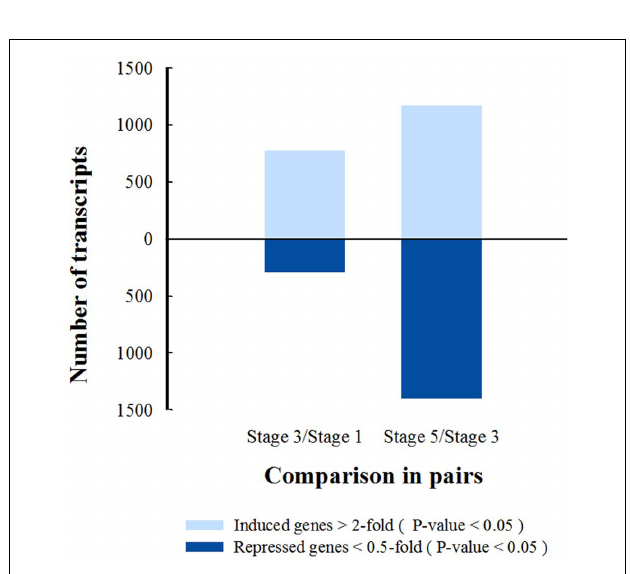
FIGURE 3 | Numbers of differentially transcribed gene in petal AZ are obtained from comparison of stages 3 and 1, or stages 5 and 3, P -value <